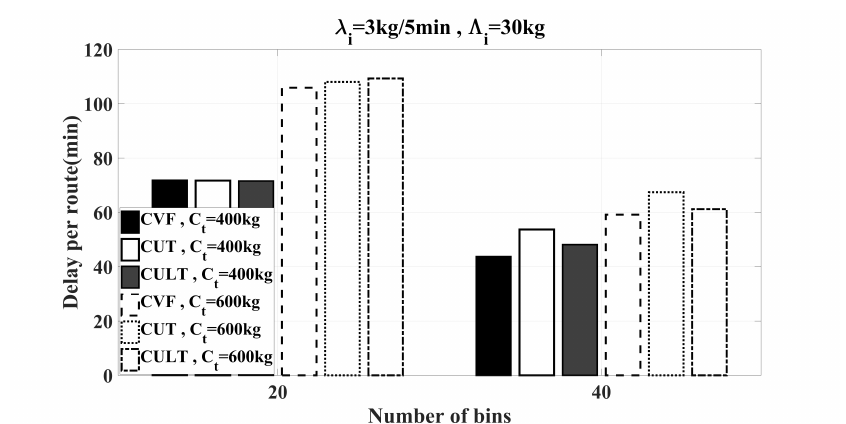
Figure 13. Delay per route: Bin count when the truck capacity was